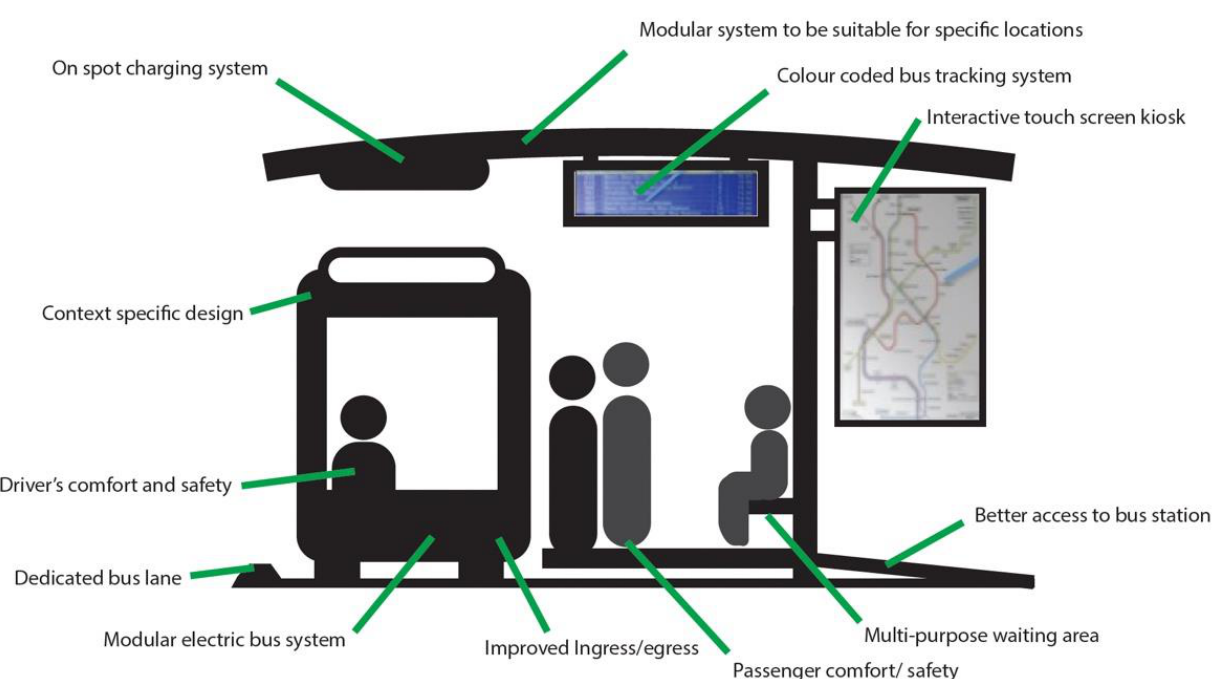
Figure 6. Proposed system diagram for an improved bus infrastructure.